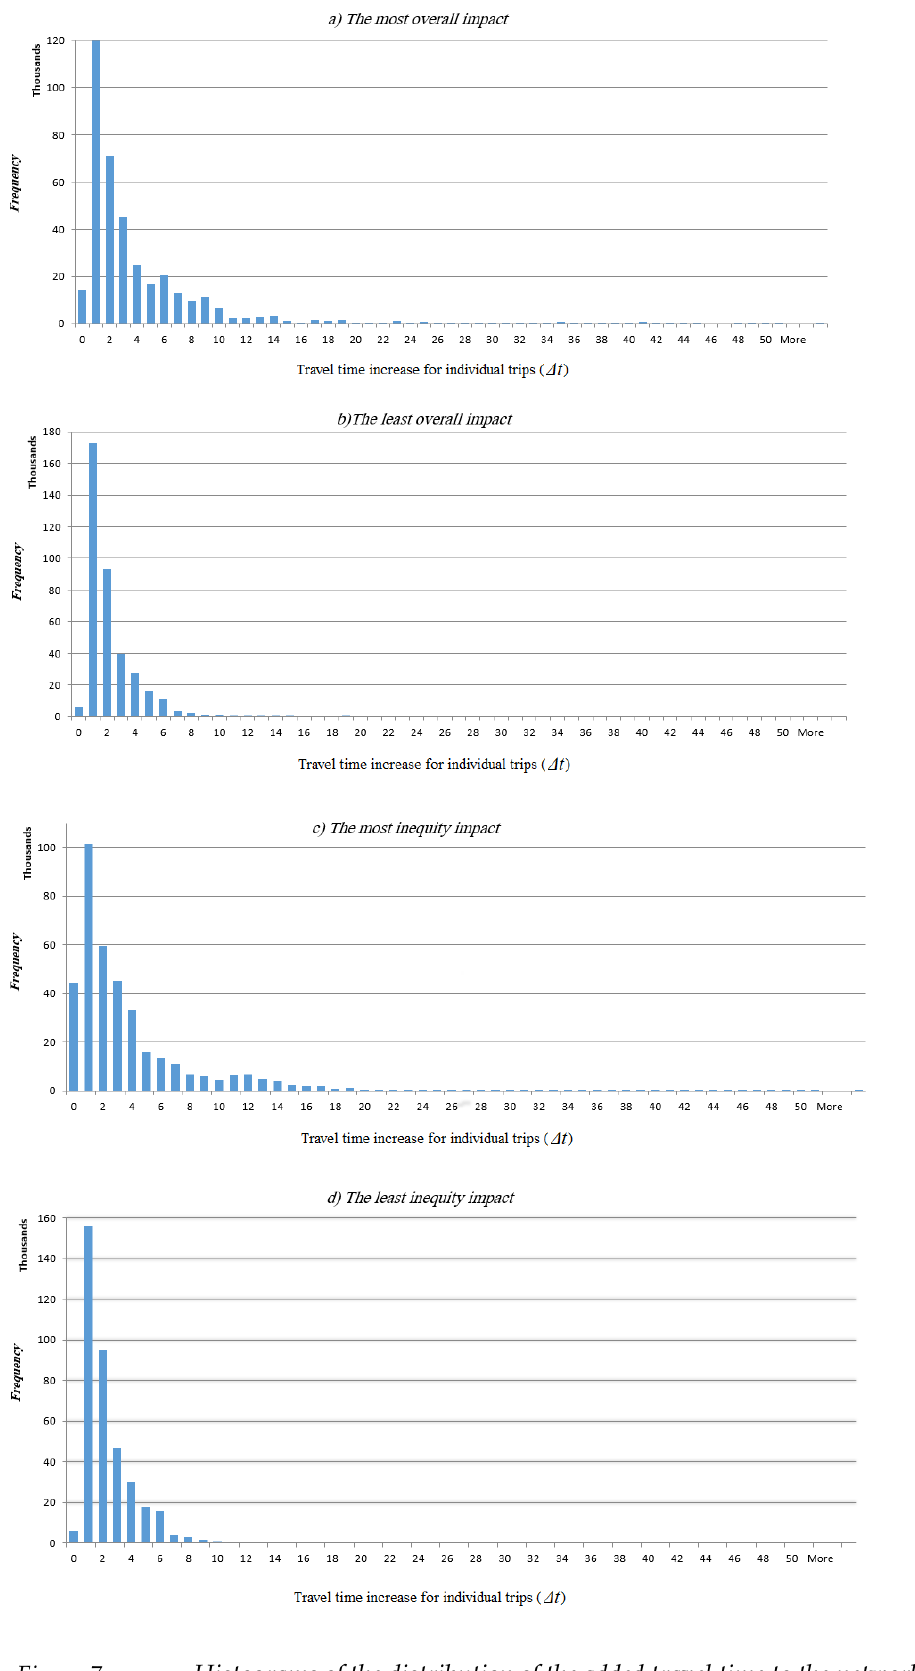
Figure 7. Histograms of the distribution of the added travel time to the network users for four disrupted networks: a) the most overall impact, b) the least overall impact, c) the most inequity impact, and d) the least inequity